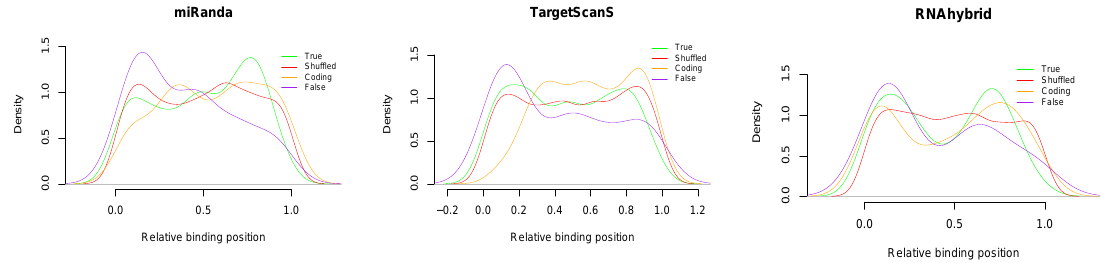
Figure 3: Characteristics of relative binding position in miRanda (left), TargetScanS (middle) and RNAhybrid (right). The density plot of relative target-binding position of true, false ori, shuffled and coding sets are depicted in green, purple, red and orange